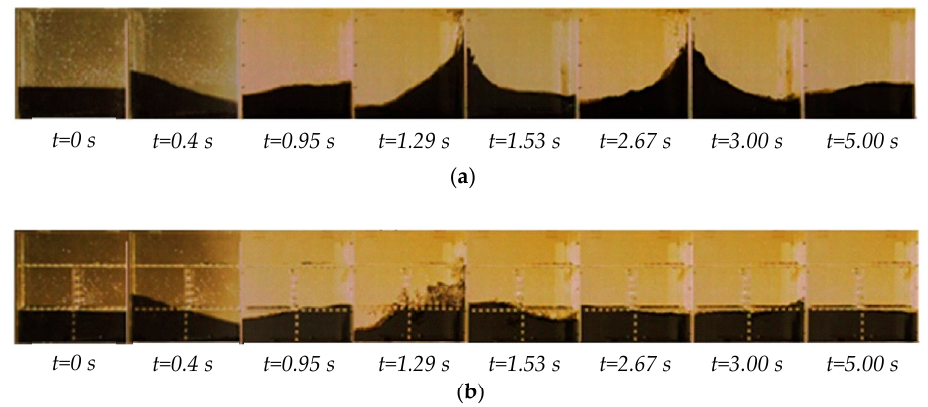
Figure 5. Slosh impact comparison: ( a ) free moving liquid vs. ( b ) included vertical and horizontal grill with 30% liquid [79].